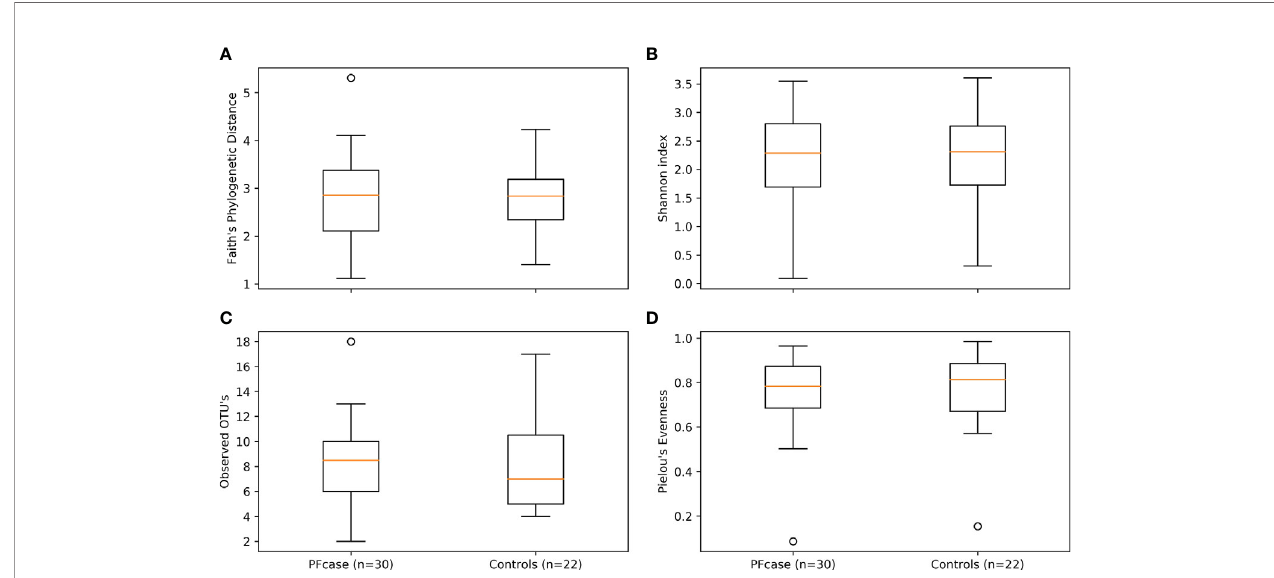
FIGURE 2 | Alpha diversity boxplots of PFcase and control samples. Metrics used are (A) Faith ’ s phylogenetic distance, (B) Shannon index, (C) Observed amplicon sequence variant ’ s (ASV ’ s) and (D) Pielou ’ s evenness. Outlier samples are shown as